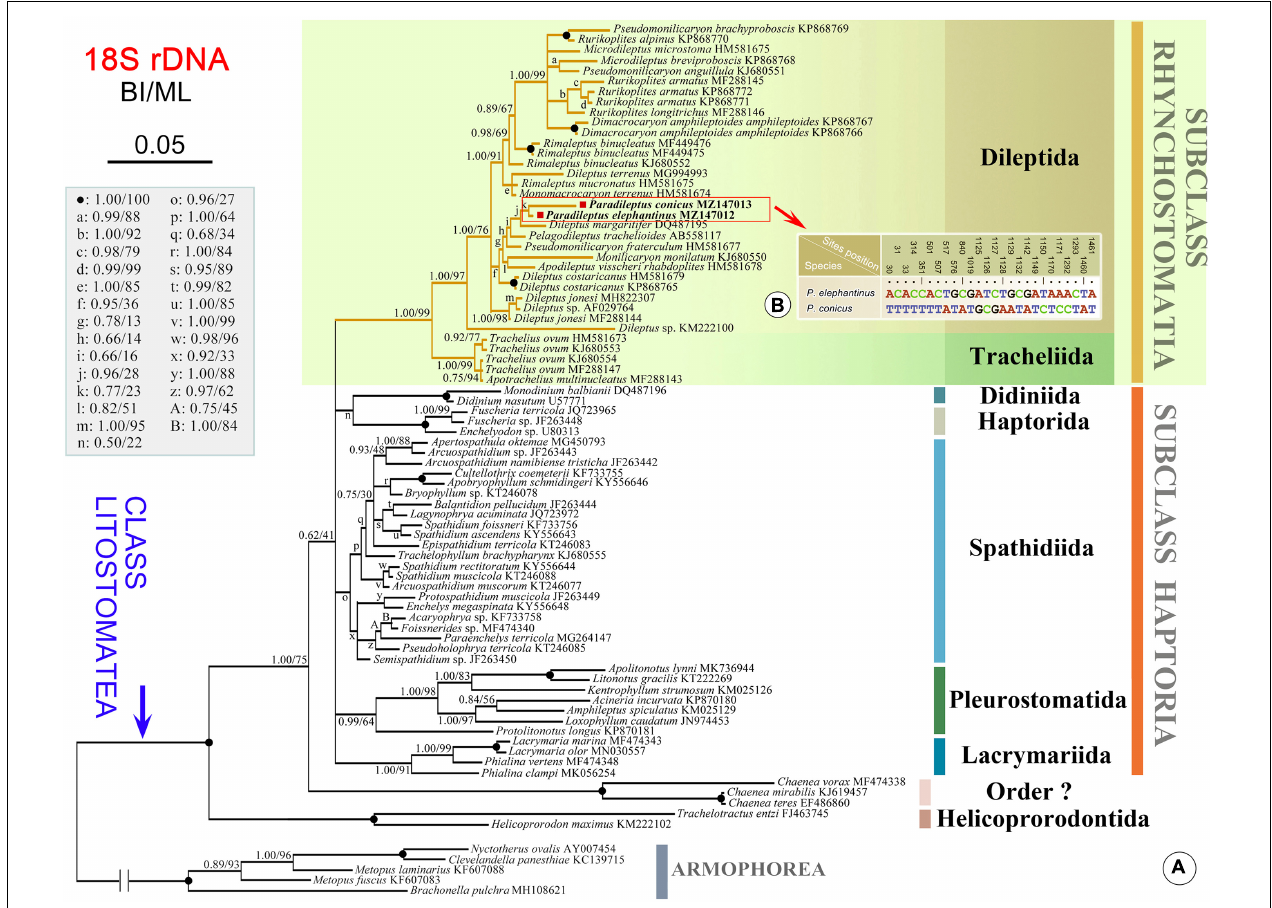
FIGURE 6 | (A) Bayesian inference (BI) tree inferred from 18S rDNA sequences (78 litostomatean and five armophorean taxa). Numbers near branches show the posterior probabilities from BI and bootstrap values from maximum likelihood (ML) analyses. The newly sequenced species in this study are shown in bold. The scale bar corresponds to 5 substitutions per 100 nucleotide positions. (B) Nucleotide differences between Paradileptus elephantinus and P. conicus based on 18S rDNA sequences. The numbers in the header indicate the unmatched site positions.